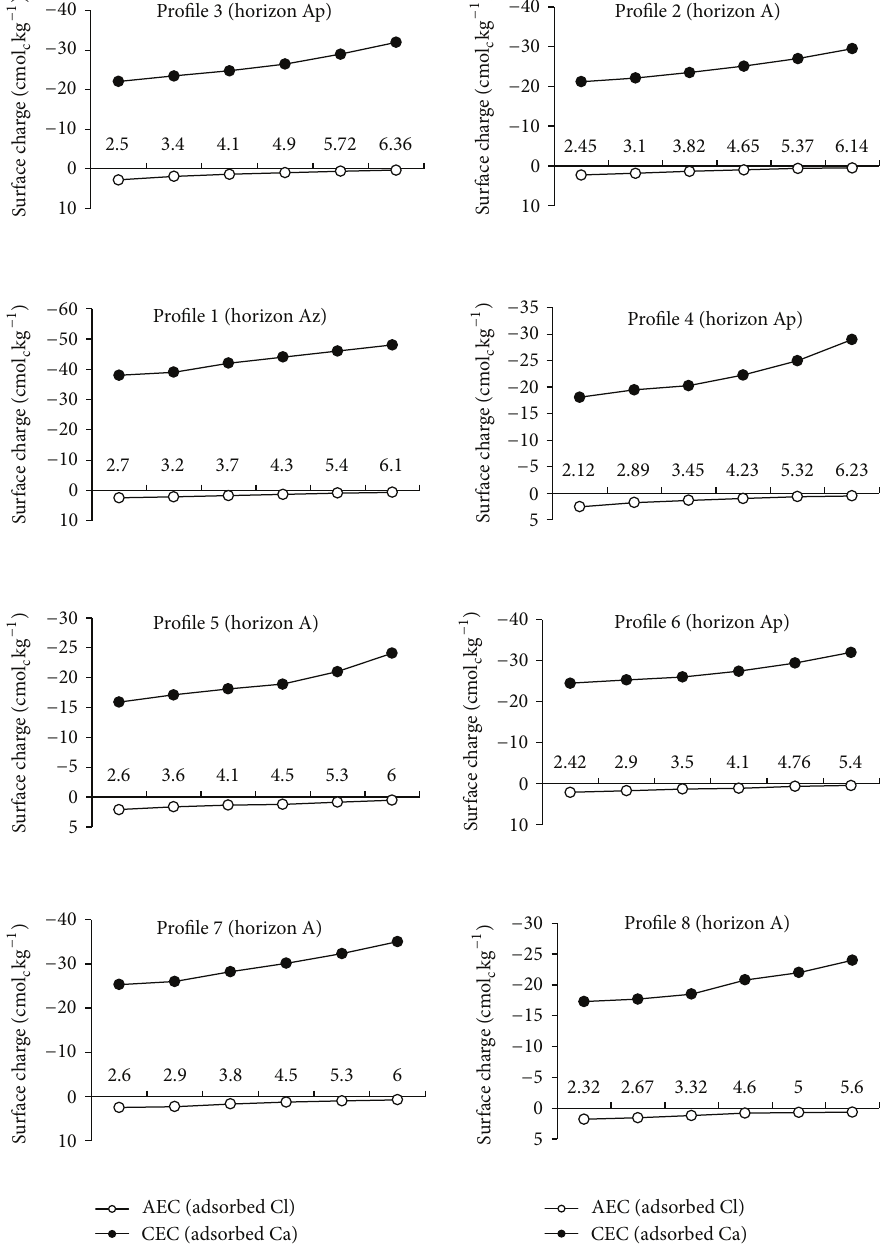
Figure 2: Charge variation with soil pH (0.002 MCaCl 2 ) for different